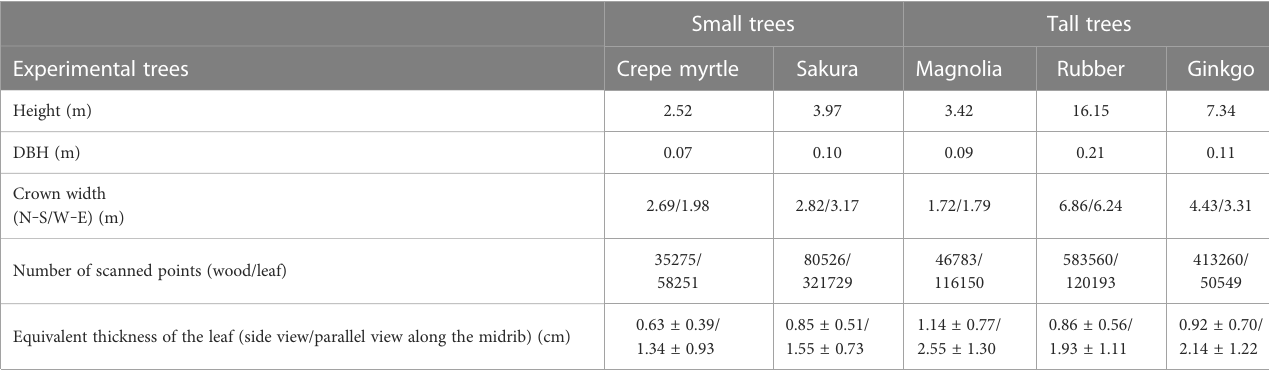
TABLE 1 Illustration of the growth attributes and the number of scanned points for the fi ve studied